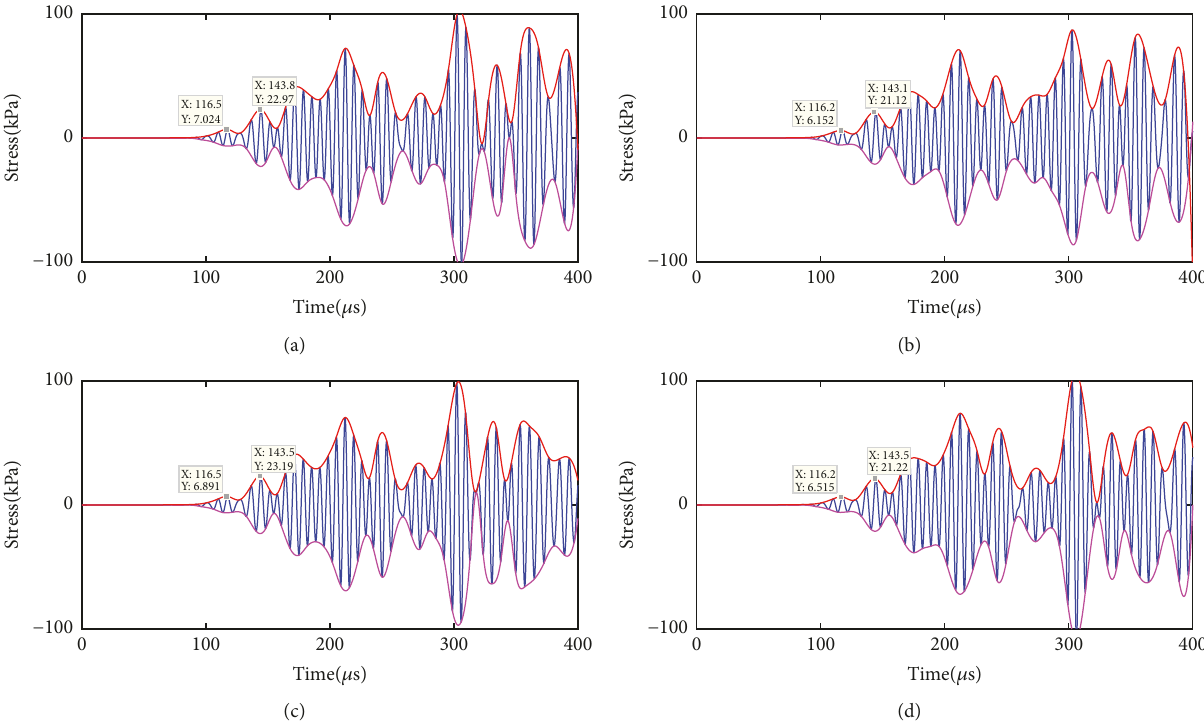
Figure 14: Collected signals of stress collection points (a) no. 1, (b) no. 2, (c) no. 3, and (d) no. 4 when the rotor is at rest.